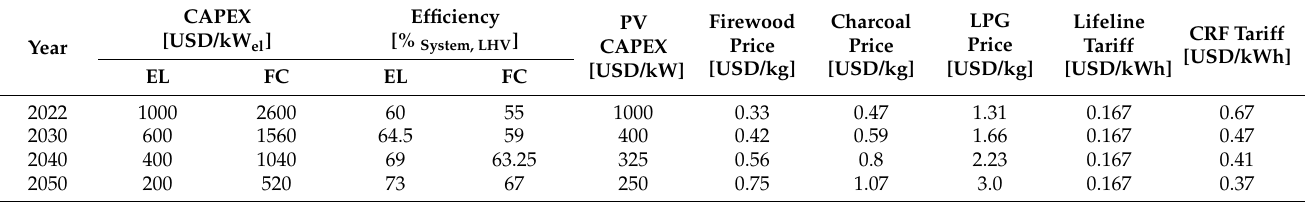
Table 5. Scenario assumptions for future development of hydrogen technology improvement